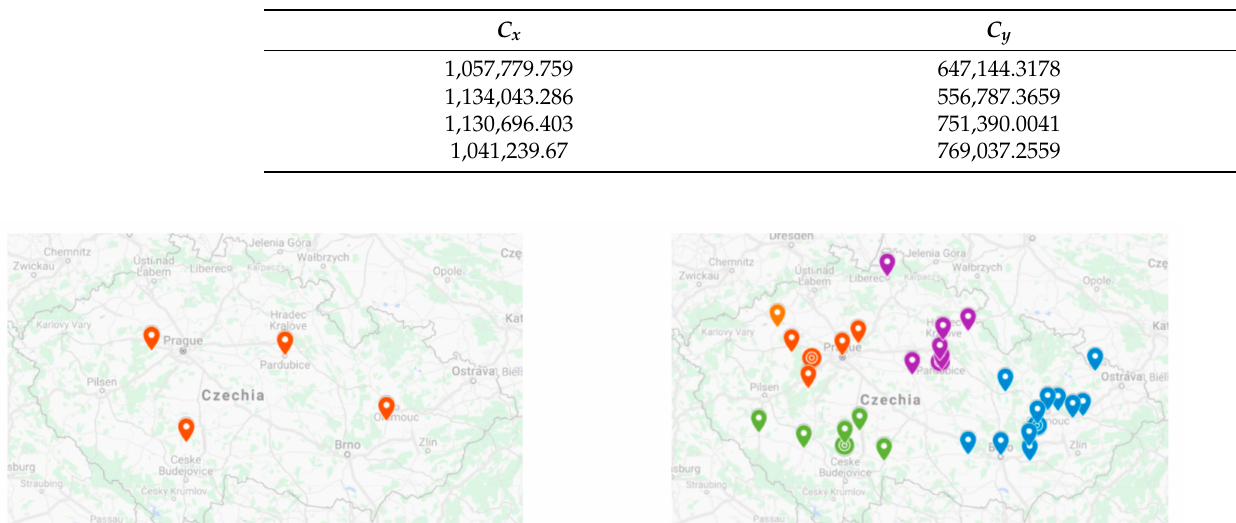
Table 10. Best solution found for benchmark E.